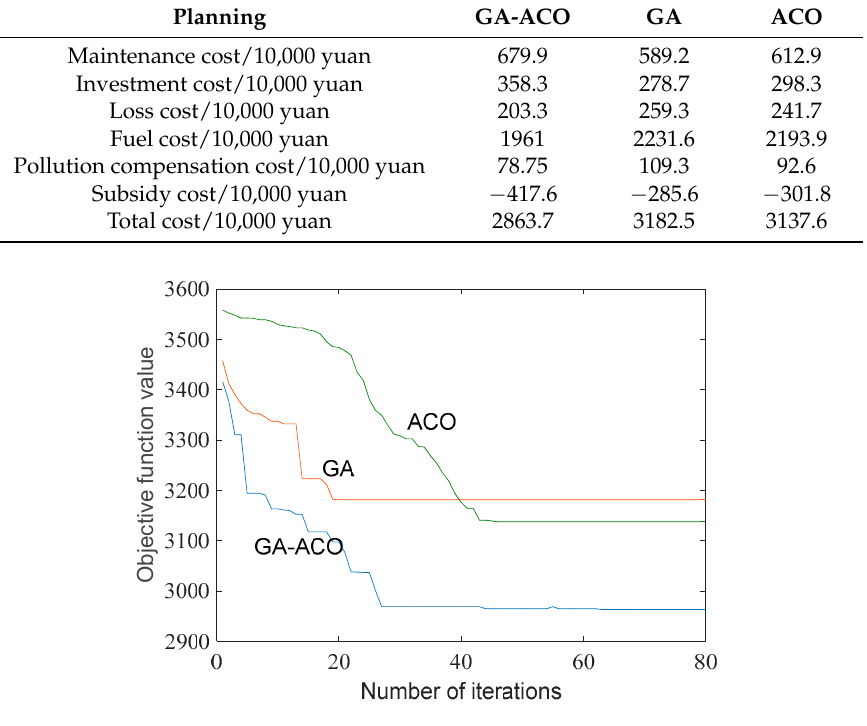
Figure 10. Optimization algorithm comparison chart.